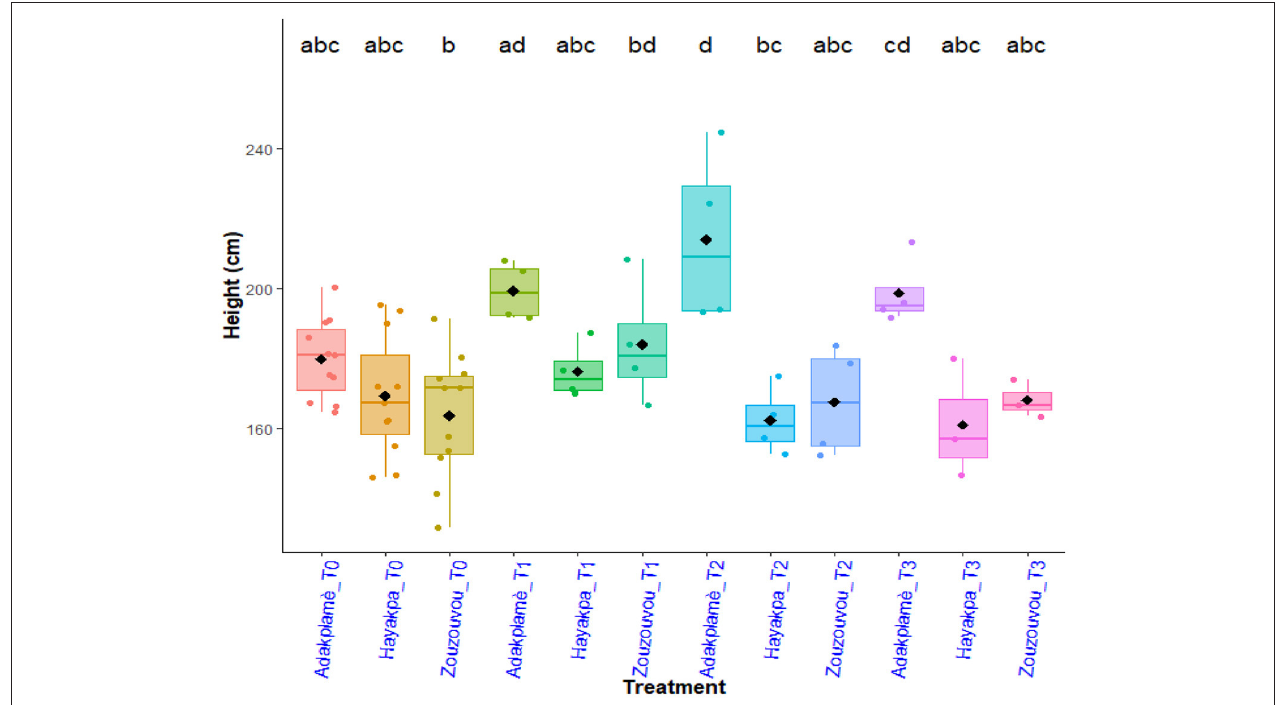
FIGURE 3 | Height of maize plants as a function of treatment and area. T 0 :100% NPK + Urea; T 1 : clay + P. putida + ½ NPK + Urea, T 2 : peat + P. putida + ½ NPK + Urea, T 3 : clay-peat + P. putida + ½ NPK +